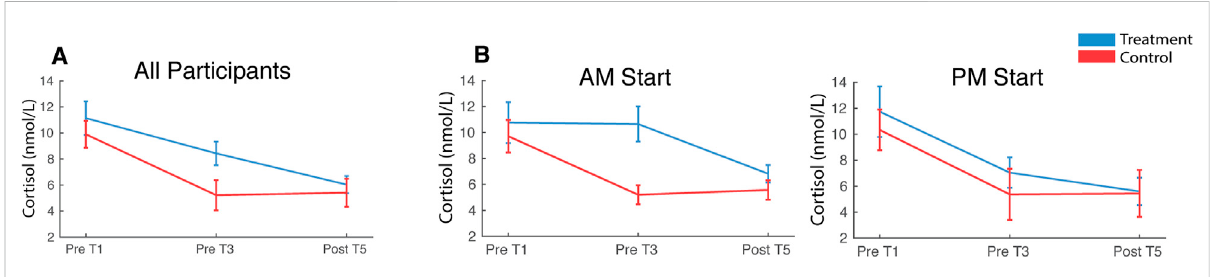
FIGURE 12 Cortisol. Saliva samples wereacquiredprior to the fi rst and third pressortests andattheend of thesession. Plotsdepict cortisollevels averaged across all participants (A) and split by participant start time (B) . Error bars represent